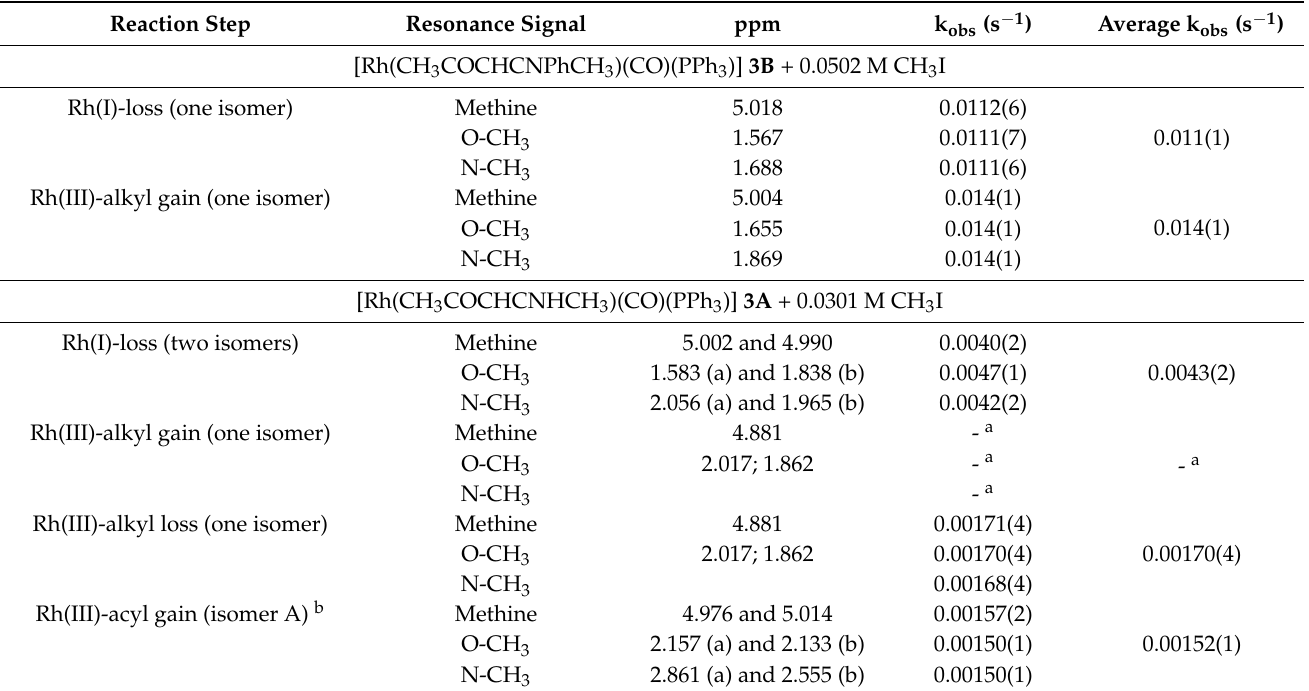
Table 5. Pseudo first-order reaction rate constant of the methine and methyl resonance signals of the oxidative addition reaction between CH 3 I and [Rh(N,O-BID)(CO)(PPh 3 )], as obtained from an NMR kinetic